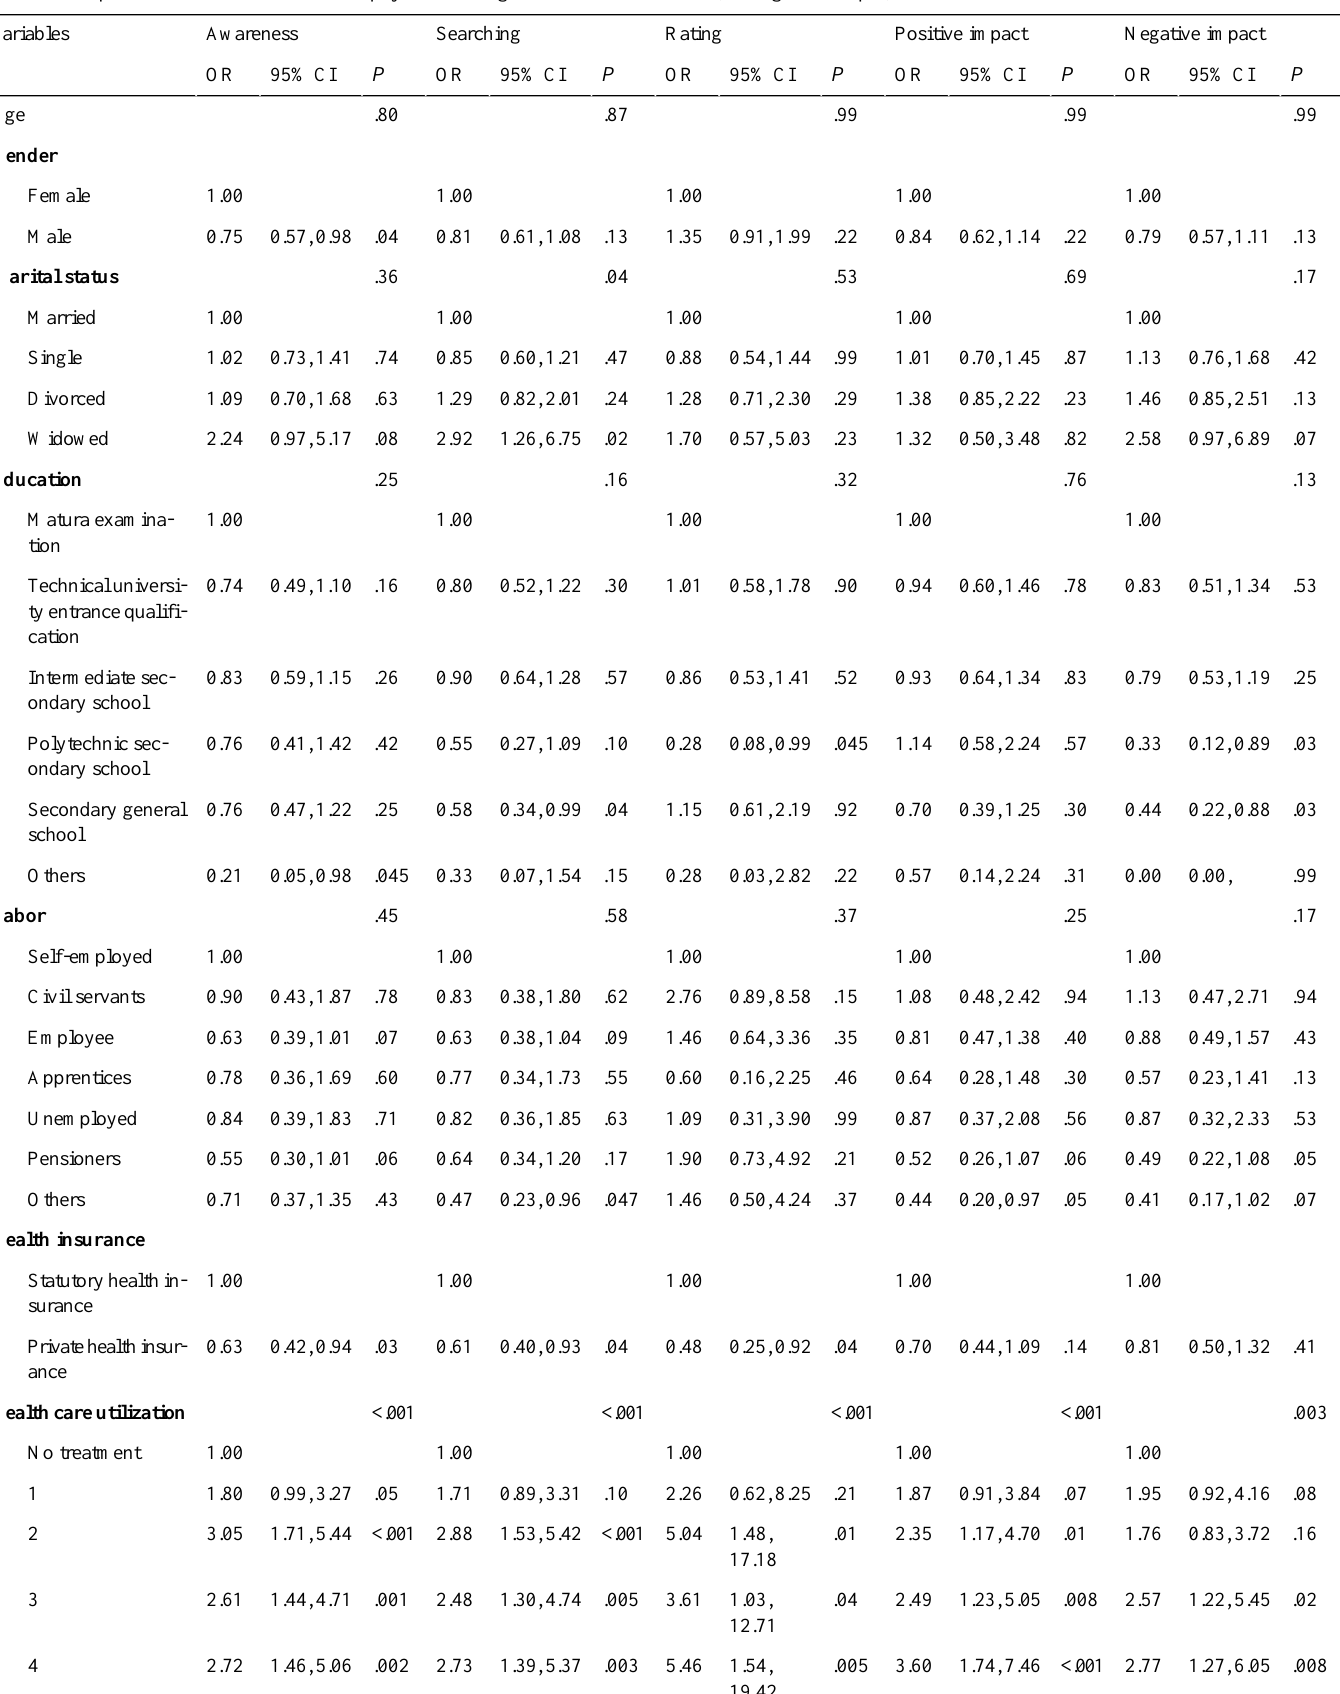
Table 3. Independent factors associated with physician-rating website relevant issues (unweighted sample).